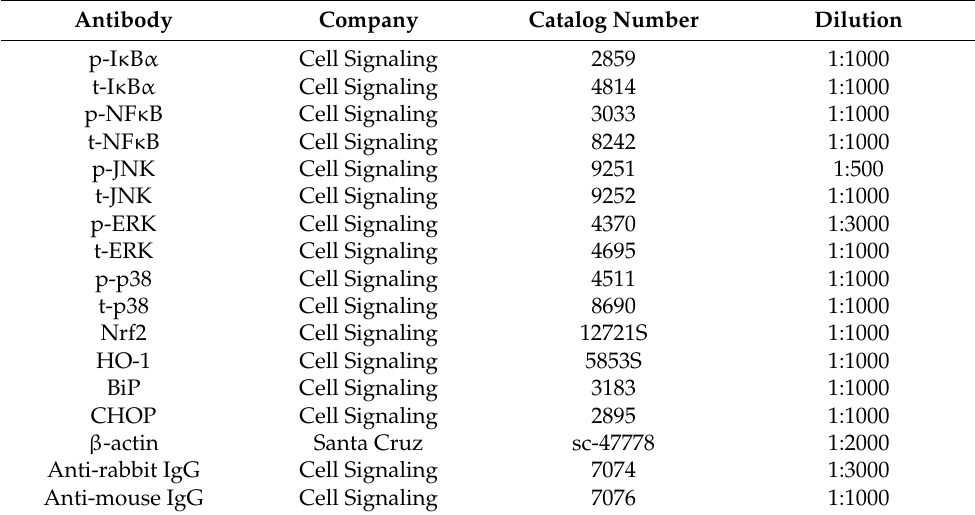
Table 4. List of antibodies for western blot analysis.